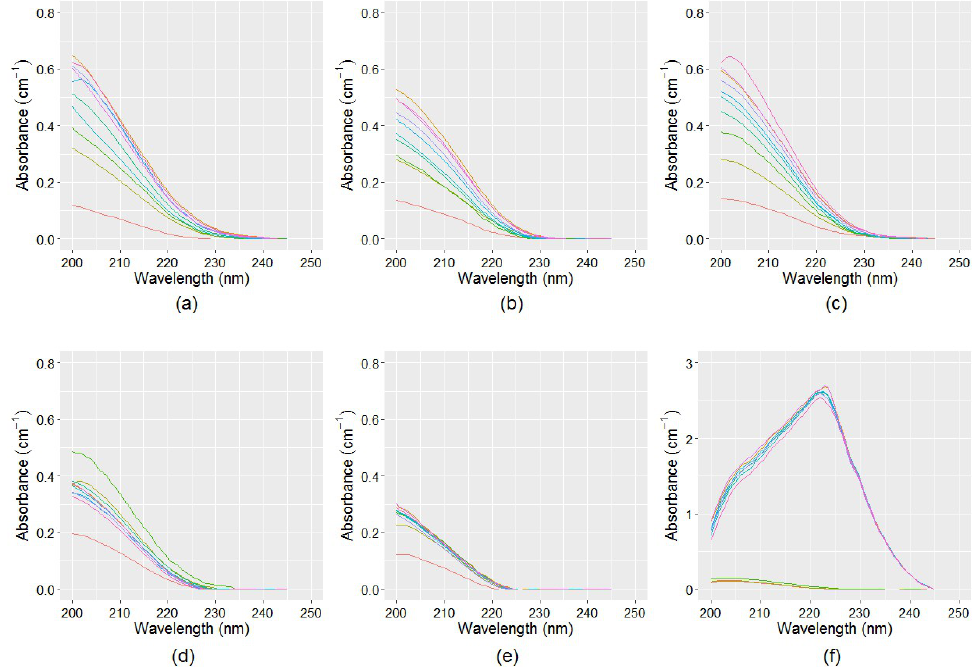
Figure 7. Isolated NO x − spectra for a period of eight weeks: ( a ) TB-WTP unprocessed sample (sam- ple1); ( b ) TB-WTP 0.22 μm filtered sample (sample2); ( c ) TB-WTP enhanced sample (sample3); ( d ) Meningie unprocessed sample (sample4); ( e ) Meningie 0.22 μm filtered sample (sample5); and ( f ) Meningie enhanced sample (sample6).